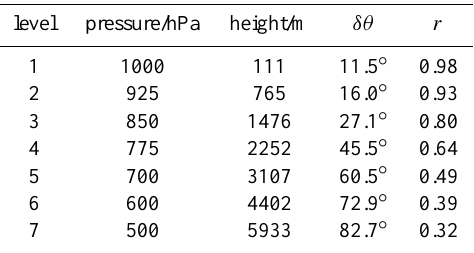
Table 2. Comparison of the winds at different ECMWF levels to the ECMWF surface level: δθ =the mean absolute deviation of wind direction, and r